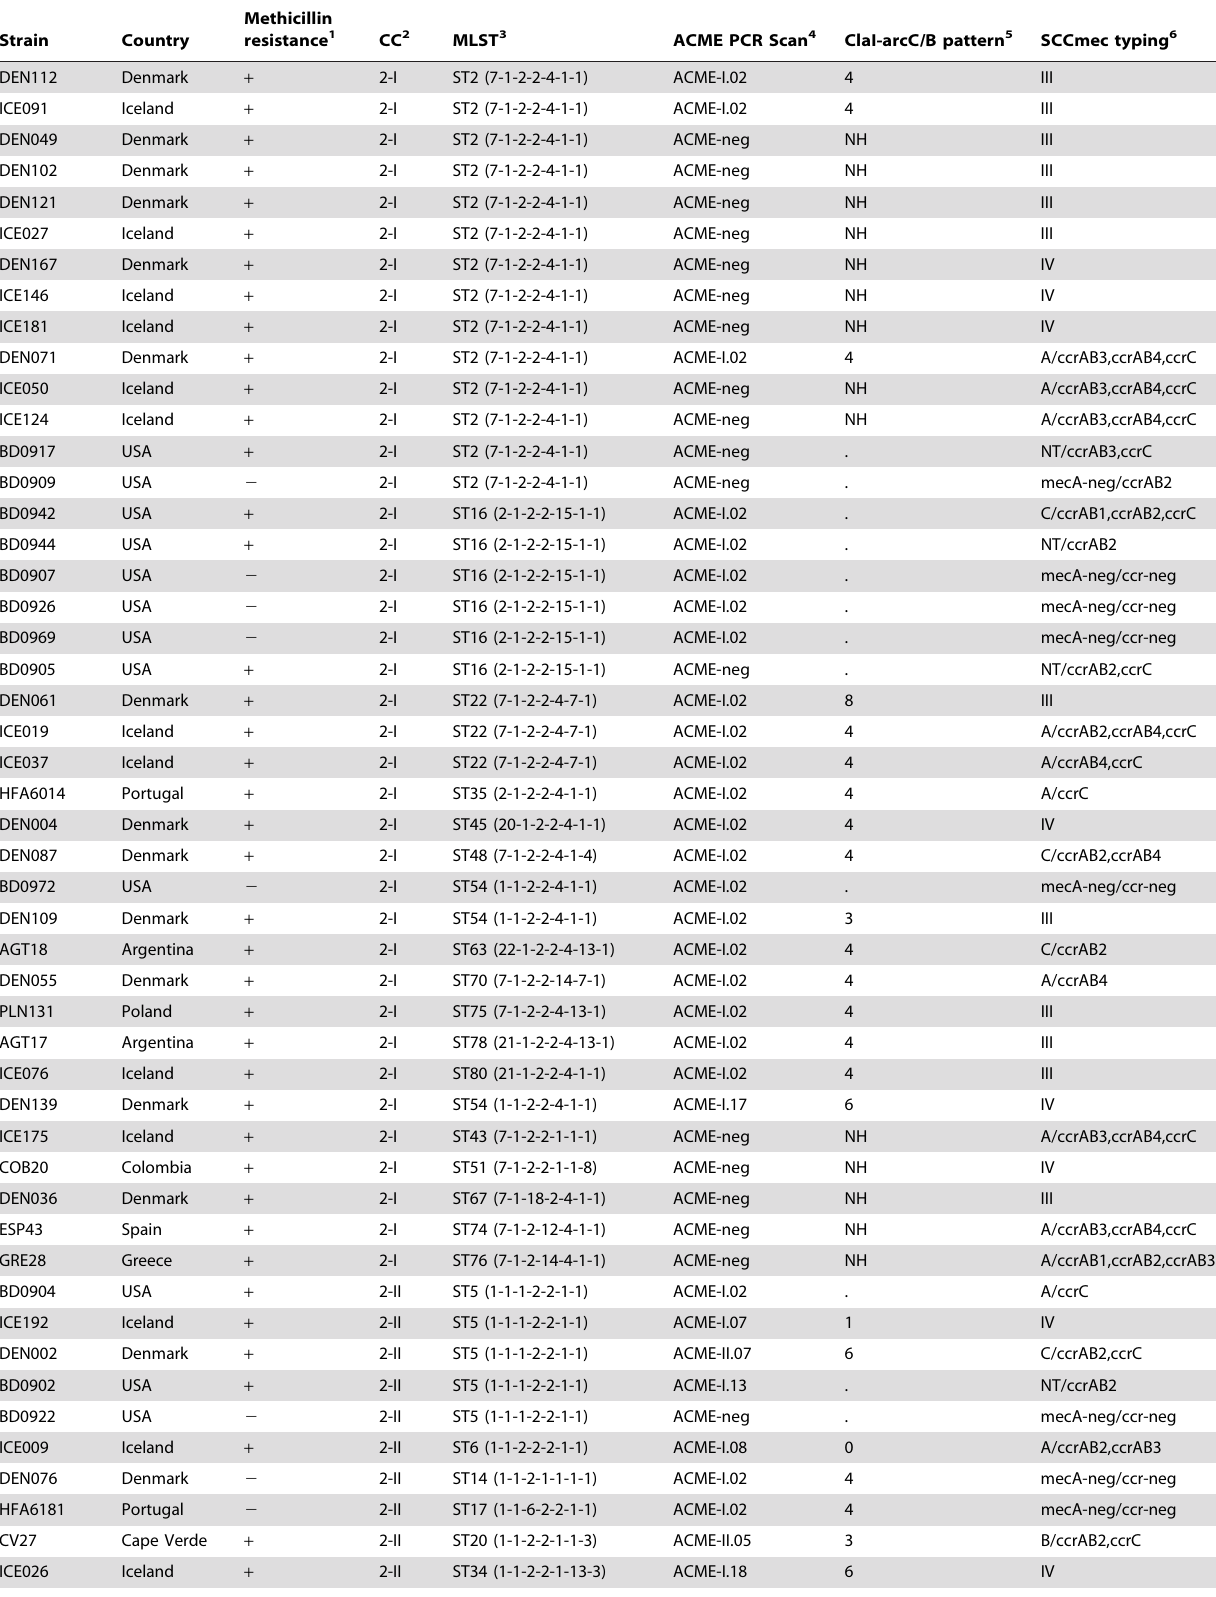
Table 1. Diversity of ACME and SCC mec among S. epidermidis